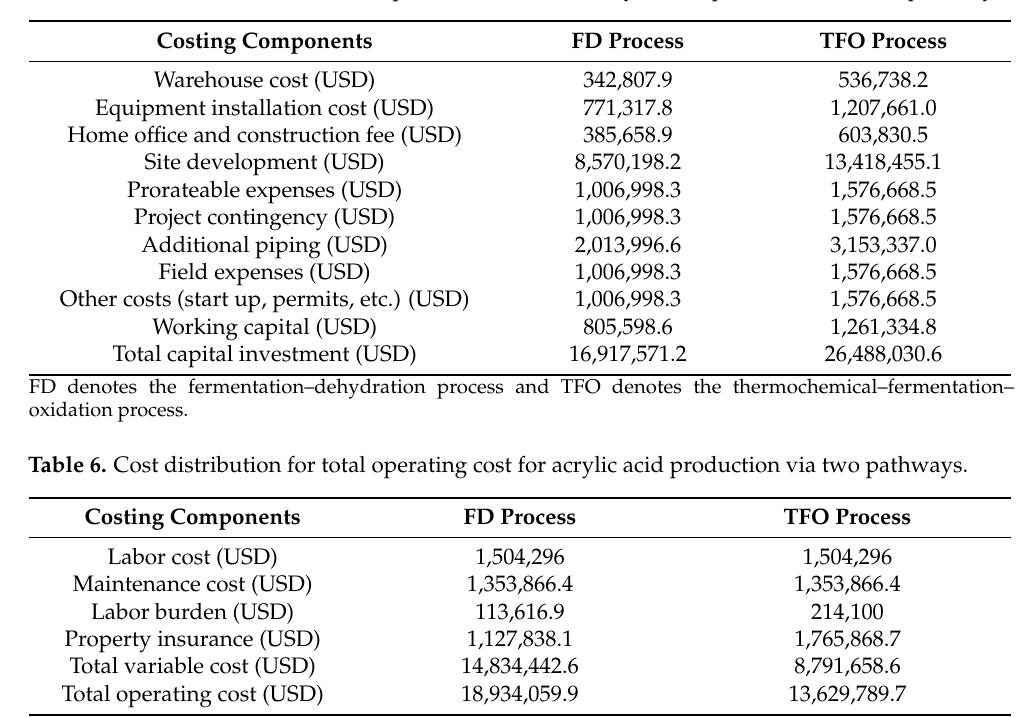
Table 5. Cost distribution for total capital investment for acrylic acid production via two pathways.